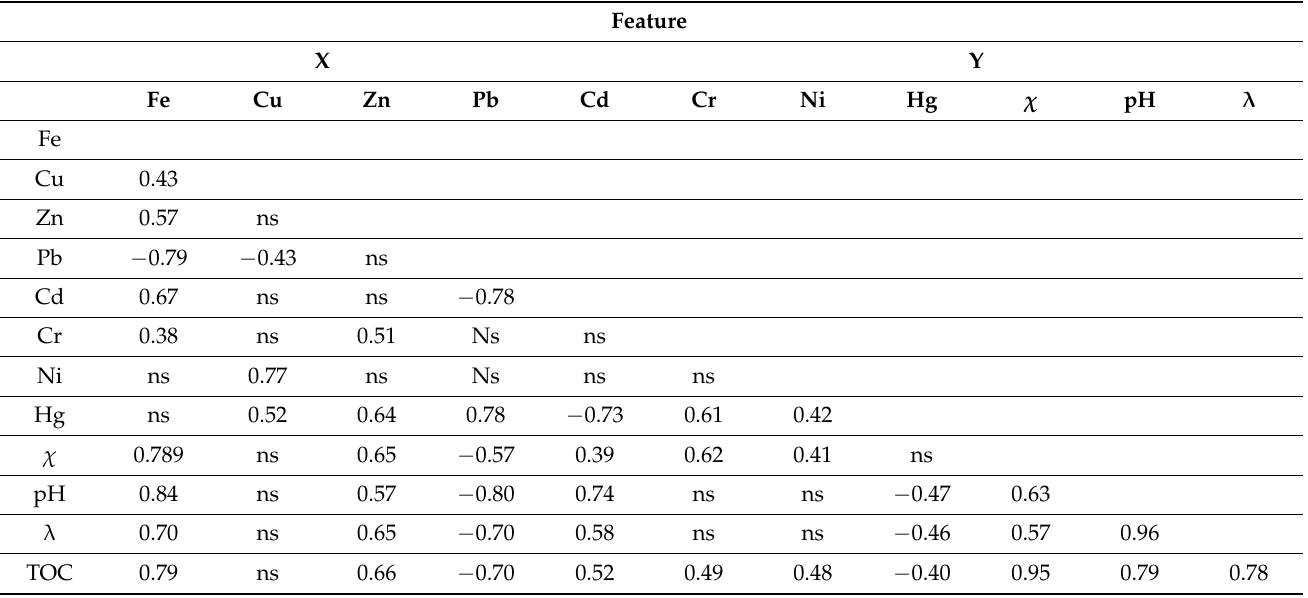
Table 5. Correlation coefficient ( r ) between some soil